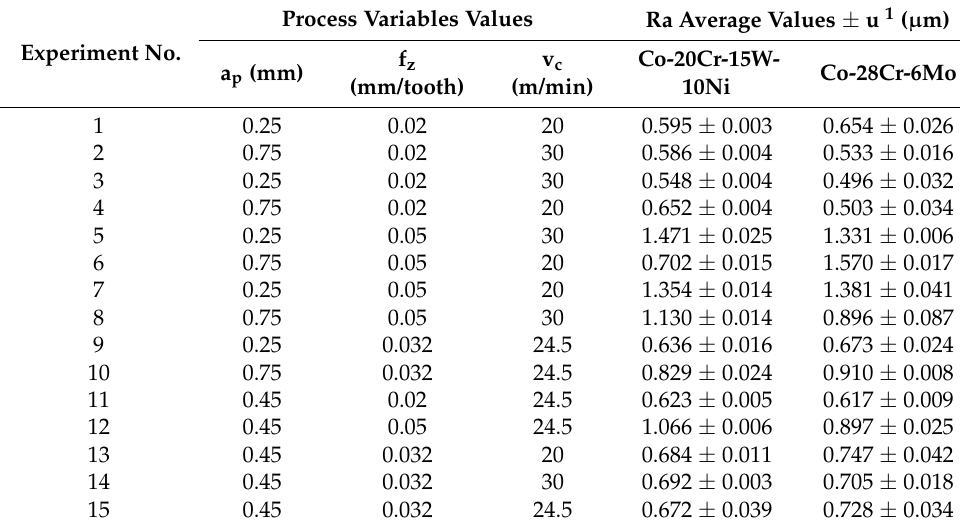
Table 5. Ra average values for the Co-Cr alloys analyzed. Experiment